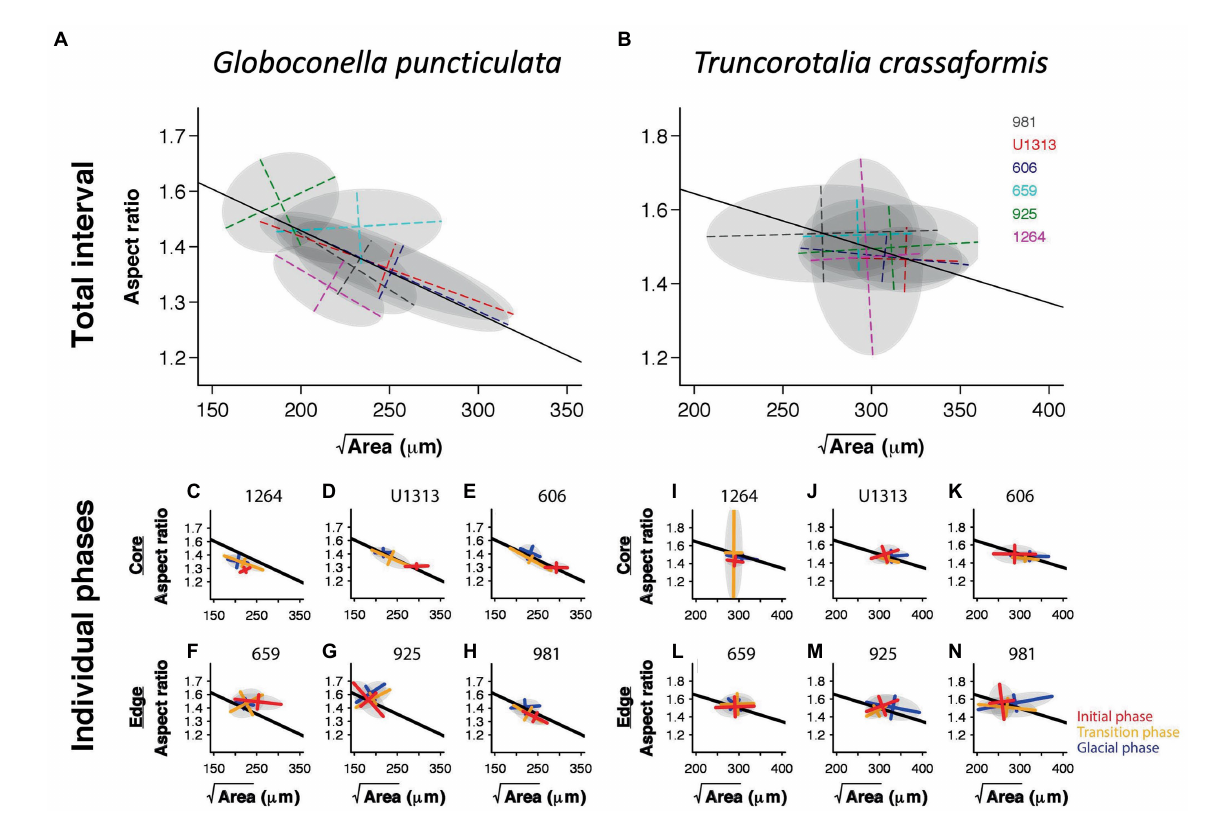
FIGURE 5 Trait covariation of size and shape in Globoconella puncticulata (left) and Truncorotalia crassaformis (right) based on time-slice averages among sites over the entire study interval (A,B) and within individual climate phases (C–N) . Solid lines indicate the regression through all site means. The gray ellipses represent 95% confidence intervals calculated from the eigendecomposition within each panel’s analytical